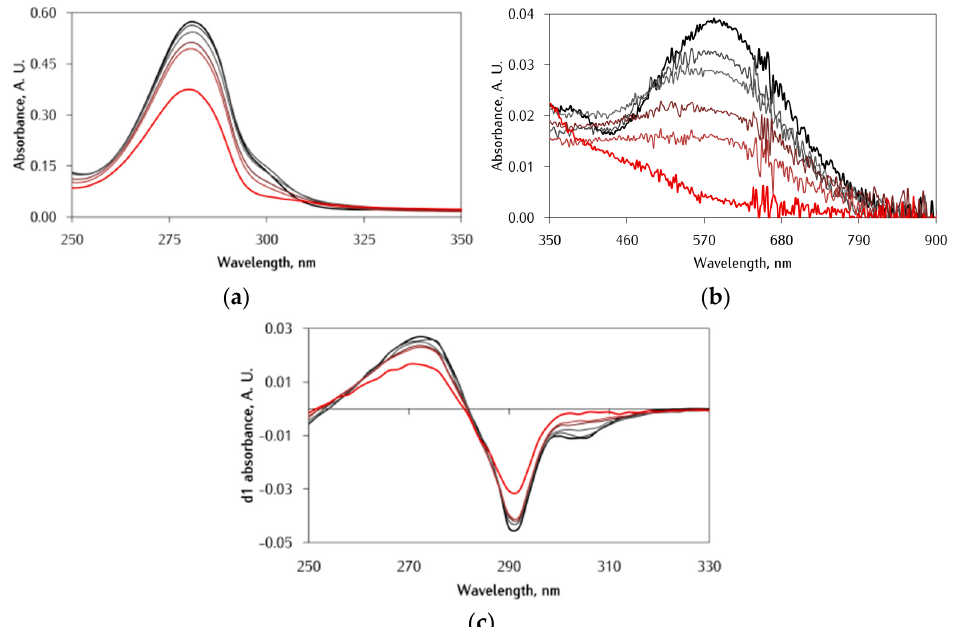
Figure 6. UV-Vis spectra of DA oxidation kinetics by Fe III -Ac- α S 119–132 complex (DA:Fe 20:1) in 10 mM Mops bu ff er pH 7.0 and 37 °C; progression of time is rendered as color hue transition from black (0 h) towards red (24 h). Spectra were recorded at 0, 1.5, 3.0, 4.5, 6, and 24 h. ( a ) 250–350 nm region magni fi cation of UV-Vis spectra. ( b ) 350–900 nm region magni fi cation of UV-Vis spectra. ( c ) UV-Vis spectra fi rst derivative.